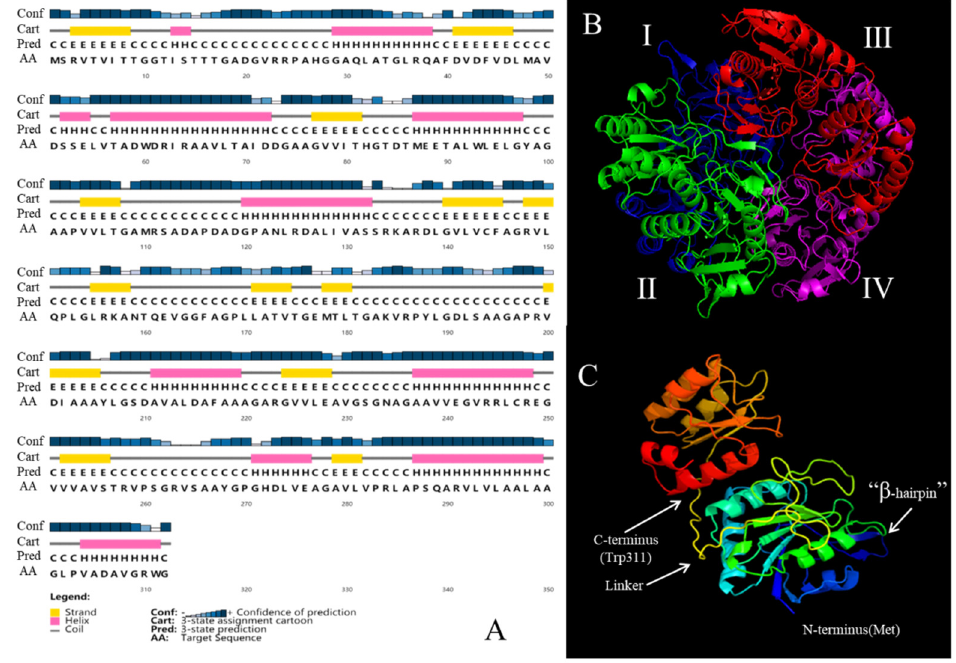
Figure 2. ( A ) Secondary structure prediction for the deduced amino acid sequence of L-asparaginase gene from Mycobacterium gordonae by PSIPRED. ( B ) Three-dimensional model prediction of L- asparaginase protein from Mycobacterium gordonae ; I (blues); II (greens); III (reds); IV (magentas). ( C ) Dimer structure model of L-asparaginase protein from Mycobacterium gordonae .